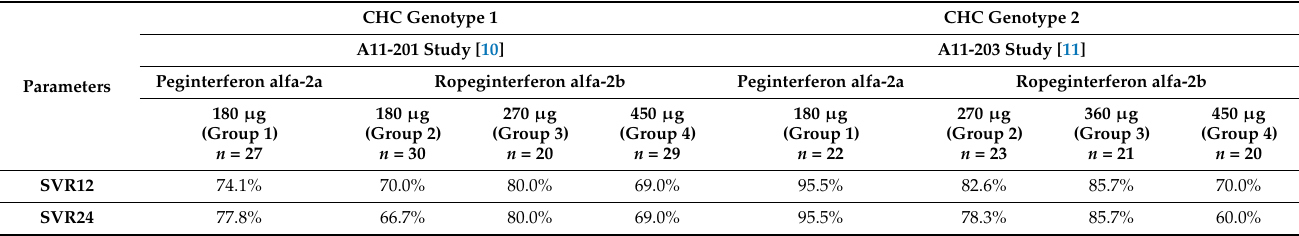
Table 2. Efficacy of ropeginterferon alfa-2b in CHC